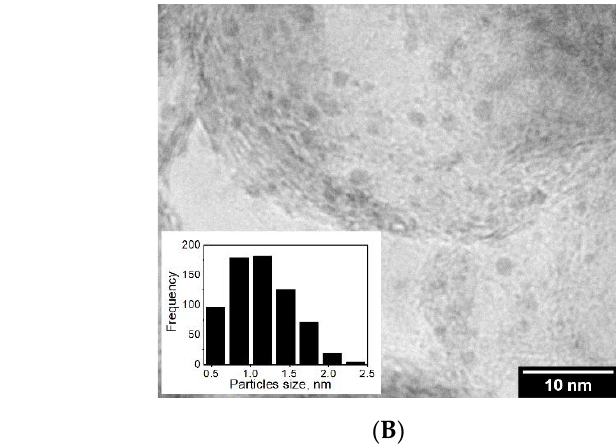
Figure 1. High-resolution transmission electron microscopy images and Ru-particle side distribution for the Ru (3%)/Sib-4 ( A ) and Ru (3%)/Sib-4-ox-450 ( B ) catalysts.